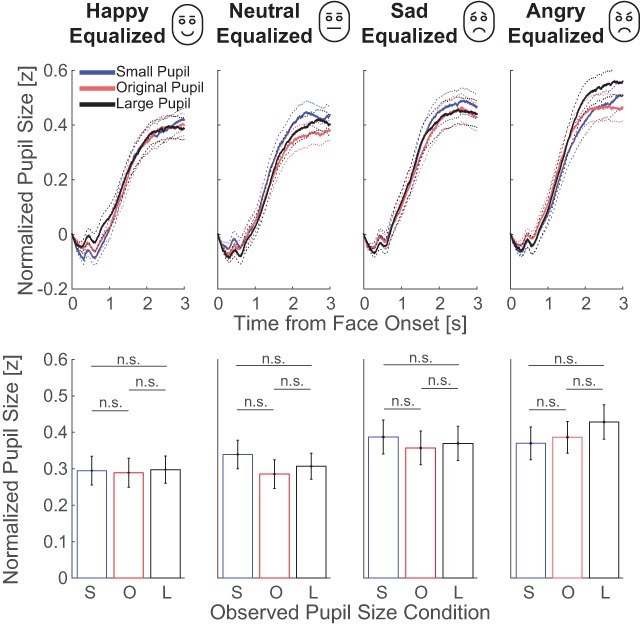
The top row shows the average change in pupil size across observers as a function of time from face onset per emotional expression condition in experiment 1. The dotted lines around the solid lines indicate standard errors of the mean. The bottom row shows the average and standard error of the change in pupil size across observers, after averaging between 1 and 3 seconds from face onset, per observed pupil-size condition (small: S; original: O; large: L; n.s.: not significant).